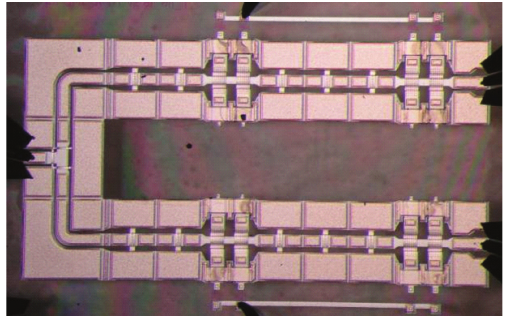
Figure 2: A photograph of a K-band RF-MEMS SPDT switch network fabricated on a quartz substrate (VTT process).